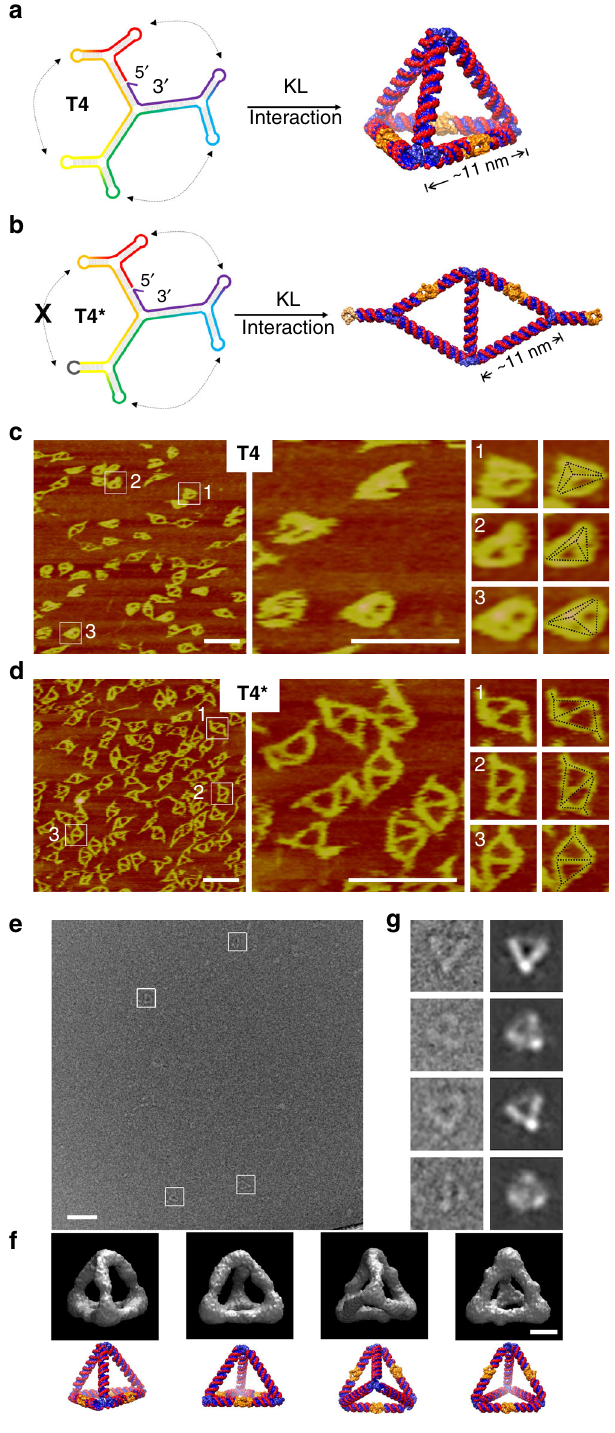
Fig. 4 Folding of a single-stranded, 4-turn, RNA tetrahedron ( T4 ). a Structural design of T4 . An RNA single strand is rainbow colored from 5 ′ to 3 ′ end. It contains four 3WJs and will fold from a 2D branching structure into a 3D tetrahedron upon the three pairs of KL interactions (indicated by dashed, double-arrowed lines). Each edge is four helical turns long. Scale bar, 50 nm. b A control molecule T4* . One loop sequence is altered to prevent one KL interaction. Thus T4* will assemble into a fl at, double- triangular shape instead of a tetrahedron. The models were built with Coot 39 and Chimera 37 . All KLs are colored orange in the model. Scale bar, 50 nm. c , d AFM images of T4 and T4* , respectively. For each structure, three particles are zoomed-in and fi tted with corresponding shapes. e , g Cryogenic electron microscopy (cryoEM) characterization of T4 . e A raw cryoEM image. Each white box indicates an individual RNA particle. Scale bar, 50 nm. f Four different views of the reconstructed structural model of the RNA tetrahedron (top) and corresponding views of the simulated model (bottom). Scale bar, 5 nm. g Pairwise comparison between raw cryoEM images of individual particles (left) and the corresponding projections (right) of the reconstructed structural model. The raw particles were selected from different images to represent views at